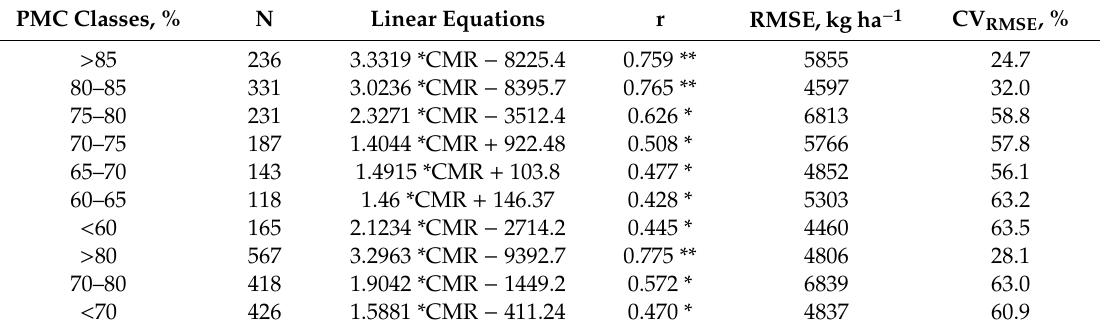
Table 2. Mean ± standard deviation of the parameters measured in the pastures of the three fields used in the calibration phase. Table 4. Linear regression equations proposed to estimate pasture green matter yield (GM), based on Grassmaster II measurements (CMR), for each pasture moisture content (PMC) class considered. PMC Classes, % N Linear Equations